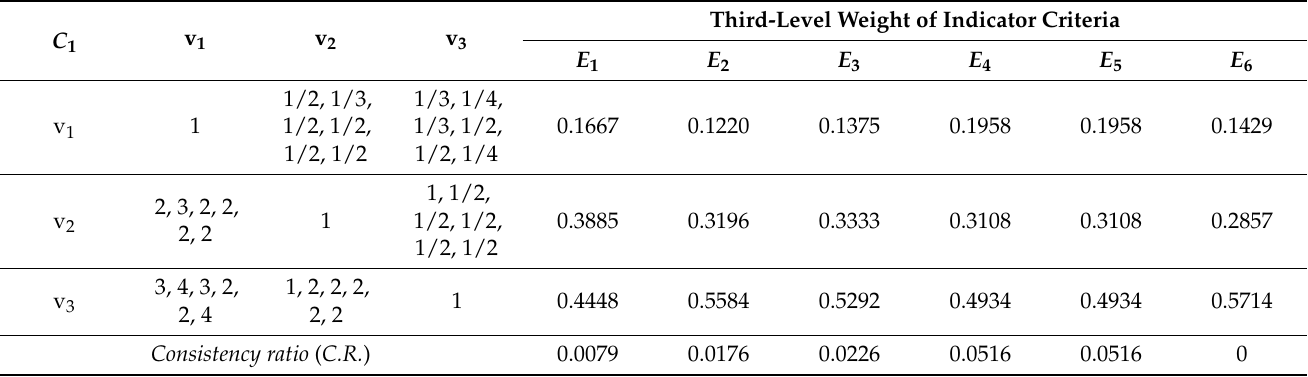
Table 10. Judgment of six experts’ scoring for the importance of economic value